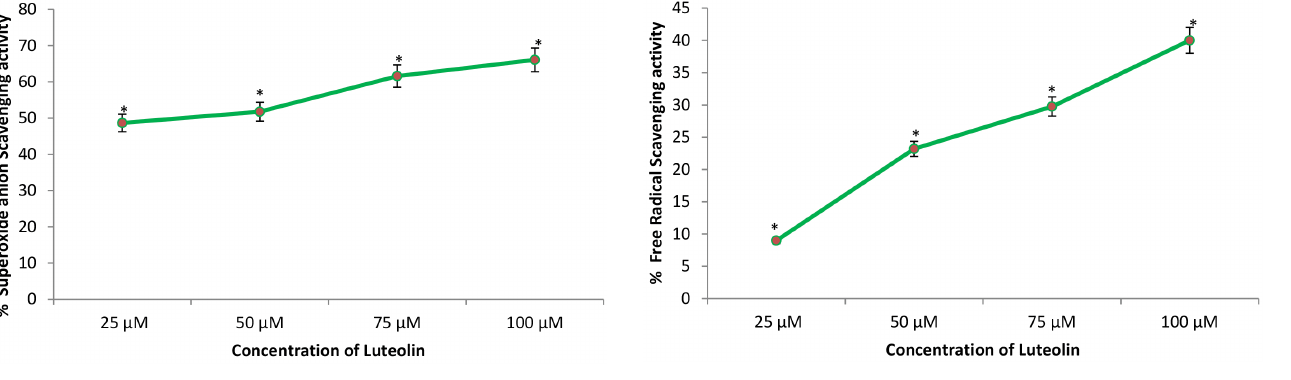
FIGURE 1S - Super oxide anion scavenging activity of luteolin. The values are the mean of five assays [*significant with respect to control, p<0.05].